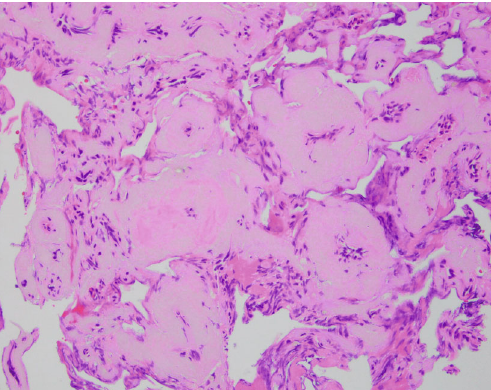
Figure 4: The resected tumor was composed of numerous blood vessels and intervening tumor cells. The blood vessels were variably hyalinized and thick-walled.